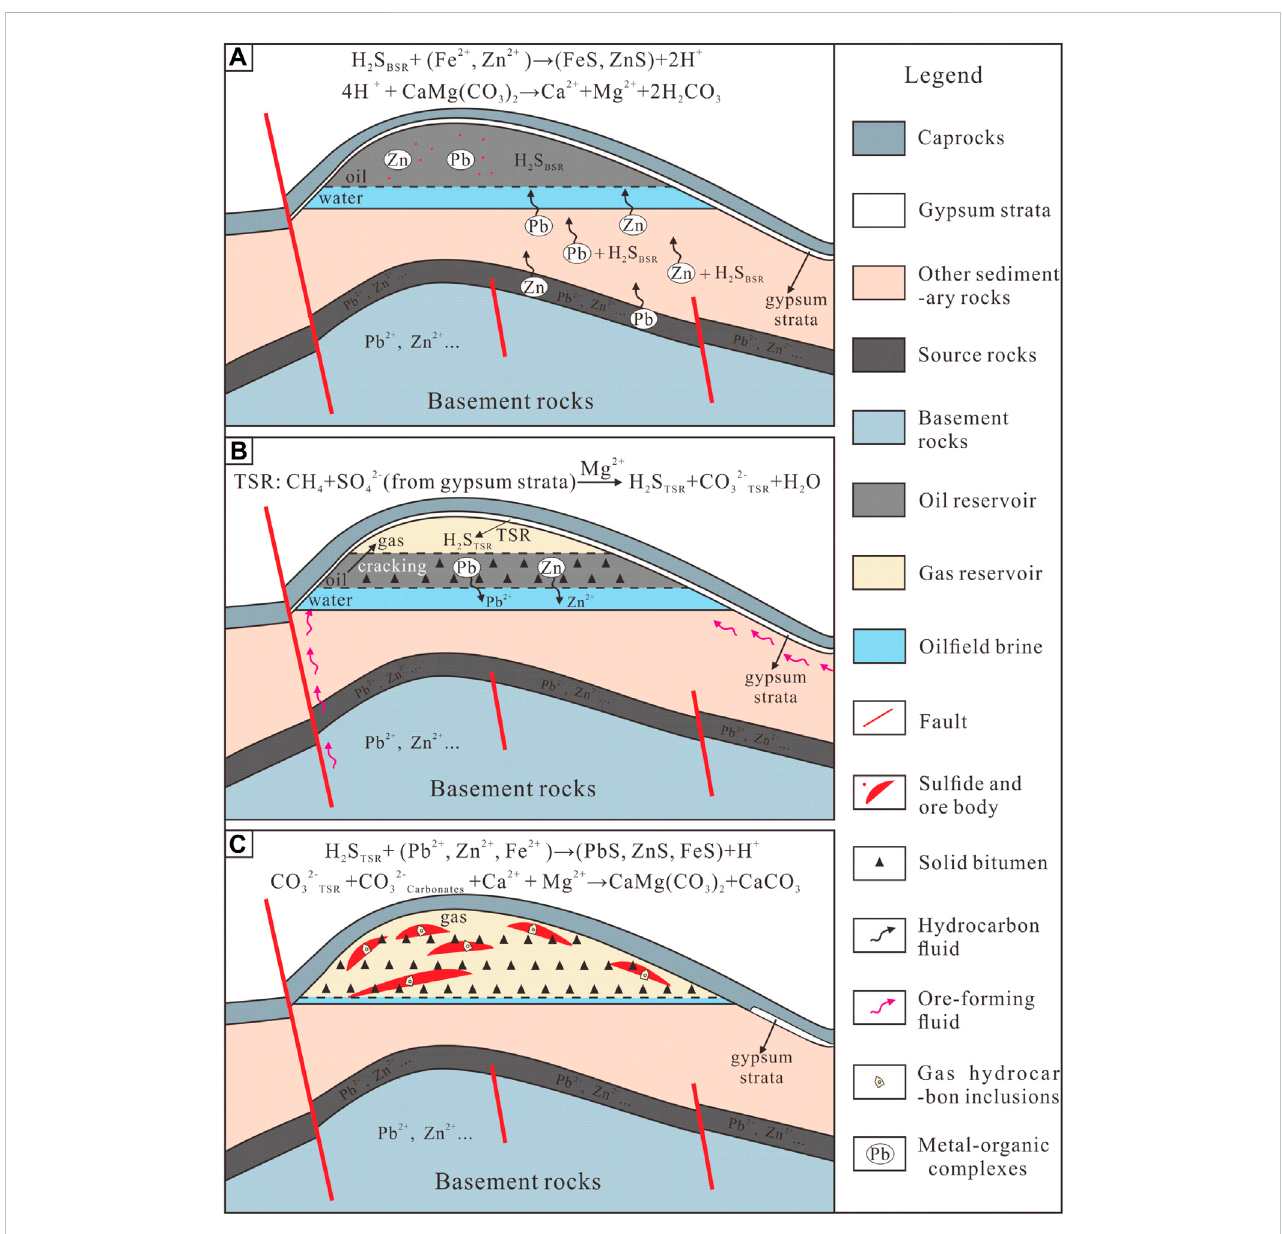
FIGURE 13 Schematic metallogenic model for the Maoping Pb-Zn deposit, showing the genetic relationship between oil and gas accumulation and lead-zinc mineralization. (A) Petroleumcarrieslead-zincmetalsintothereservoir; (B) Paleo-oilreservoircrackingintopaleo-gasreservoirandtheorganiccomplexesin petroleum are decoupled from the metals. Hydrocarbon organic gas acted as a reducing agent and transformed SO 4 2 − in the gypsum strata into H2STSR through TSR. (C) A large amount of sul fi de with heavy sulfur isotope value precipitates.